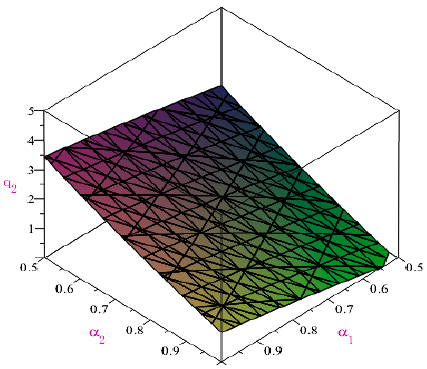
∗ with α 1 and α 2 (0.5 < α 1 ≤ 1.0, 0.5 < α 2 ≤ 2